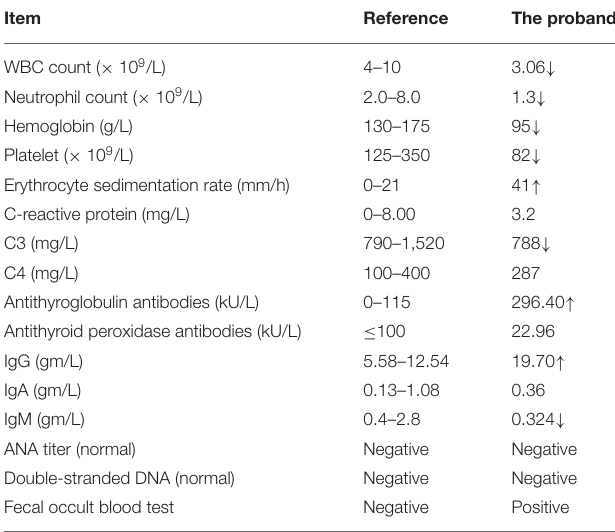
TABLE 1 | Blood analysis of the